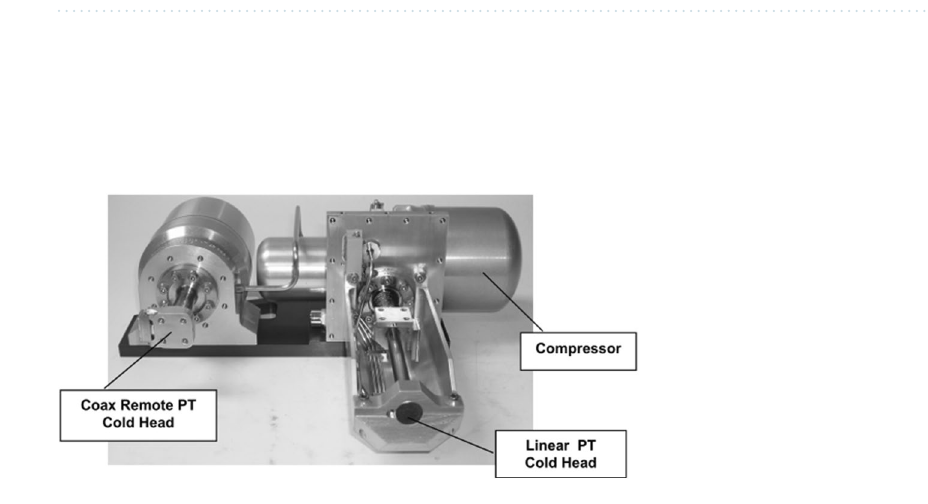
Figure 13. ABI pulse tube cooler 34